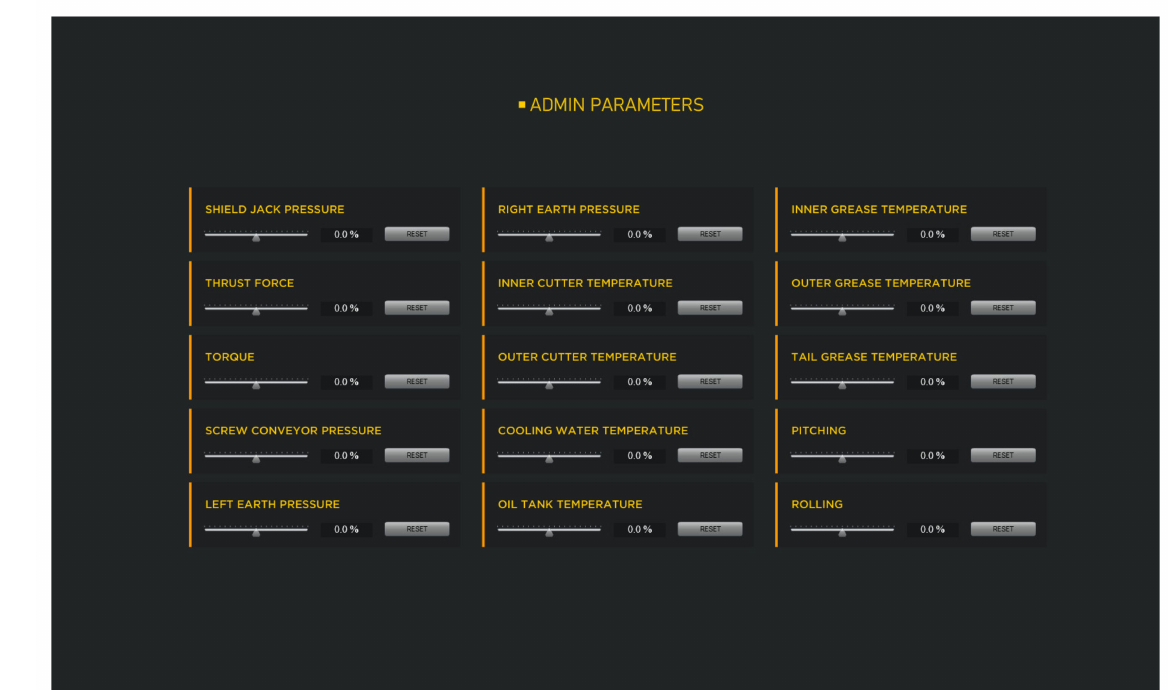
Figure 10. Instructor panel in the TBM